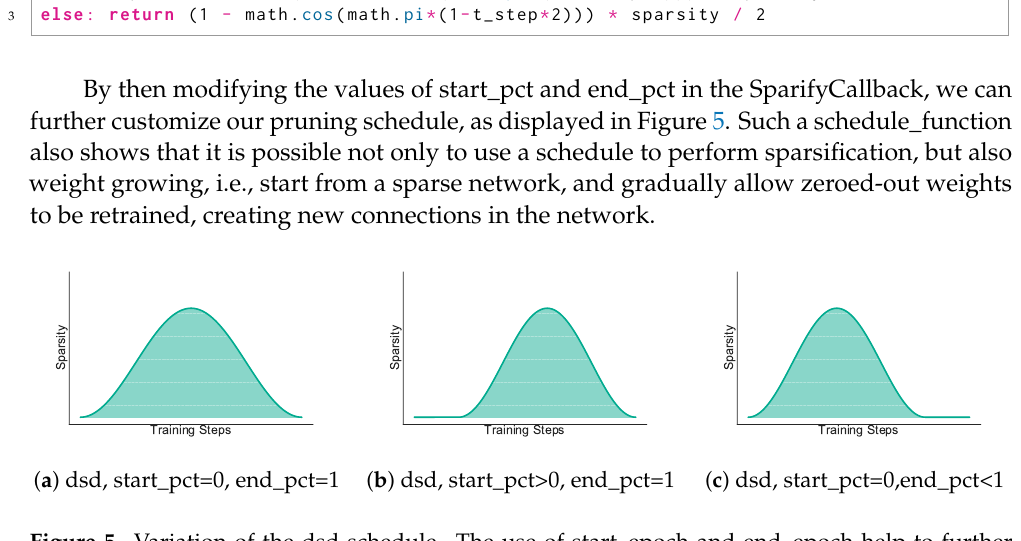
Figure 5. Variation of the dsd schedule. The use of start_epoch and end_epoch help to further customize a given pruning